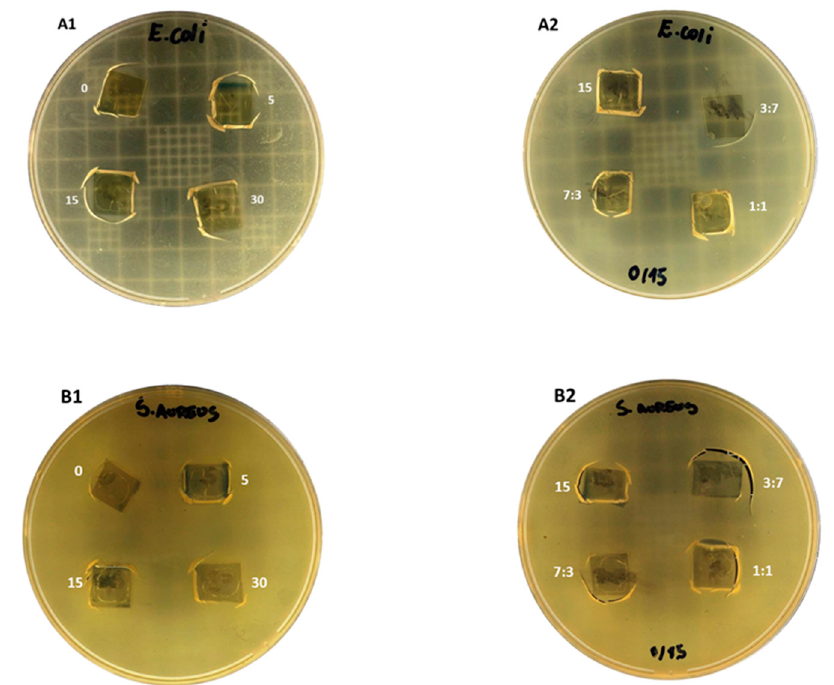
Figure 4. Inherent antimicrobial activity of biobased films. Chitosan and nanosize chitosan (S 5min , S 15min , and S 30min ) films were tested against Escherichia coli ( A1 and A2 ) and Staphylococcus aureus ( B1 and B2 ) bacteria. In Panel 1, A1 and B1 designate films composed of NS (0) or S obtained after 5, 15 and 30 min sonication times. In Panel 2, A2 and B2 , numbers designate films comprising S 15min sonicated chitosan (15) and blend films comprising NS/S 15min at 3:7, 1:1, and 7:3 ratios. Square film cuts were placed on Mueller Hinton agar plates previously seeded with 10 5 –10 6 CFU/mL indicator microorganisms. Inhibition of bacterial growth under the film squares were evaluated after incubation at 37 °C for 24 h.